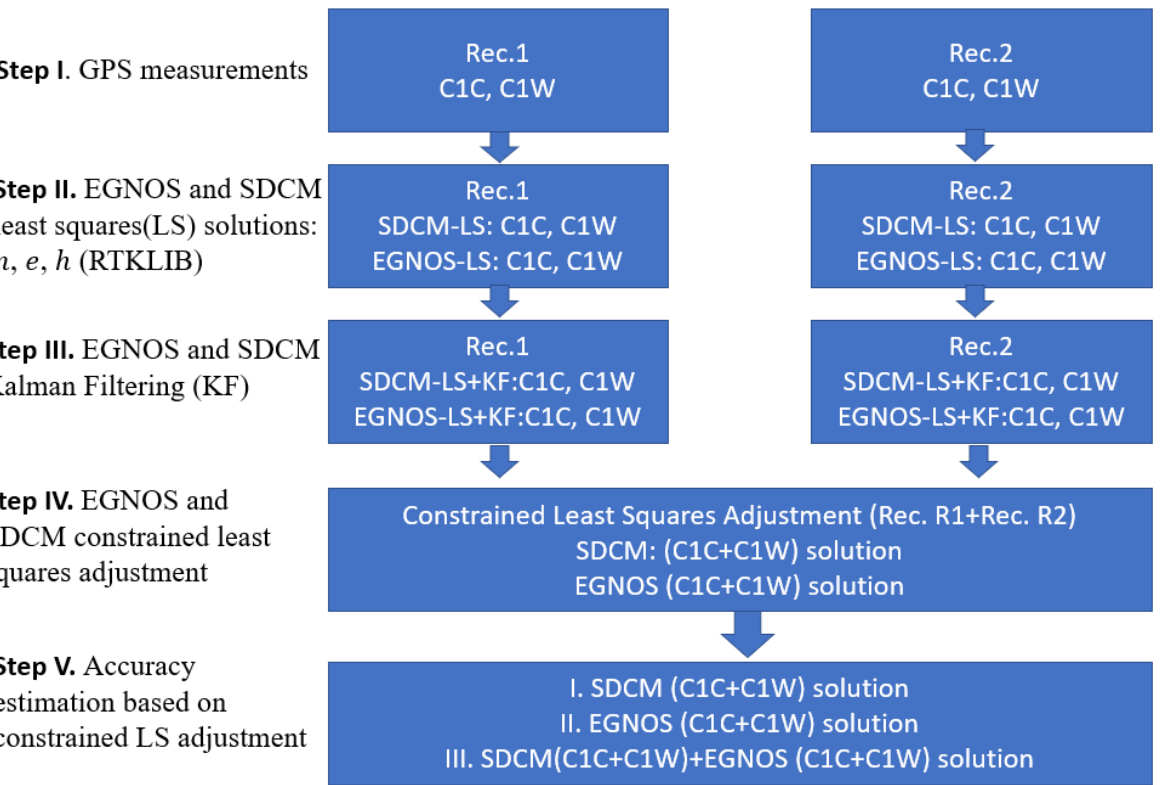
Figure 1. Diagram of double receiver EGNOS+SDCM positioning.